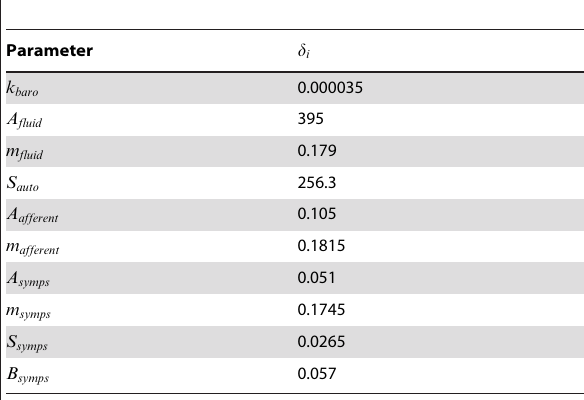
Table 5. Parameters used in the inclusive and sensitive tiers, along with the standard deviations of the jumps allowed in the steps of the Metropolis algorithm.0.